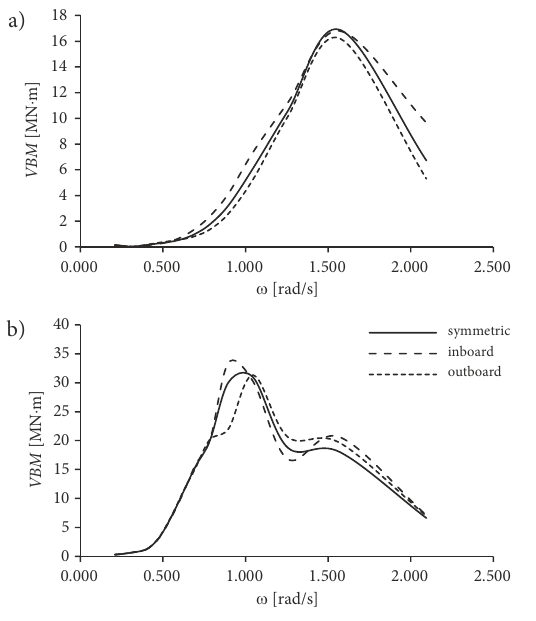
Figure 8. RAOs of vertical shear forces VSF in: a – beam seas; b – bow quartering seas